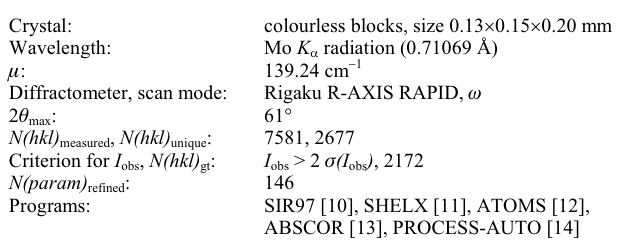
Table 1. Data collection and